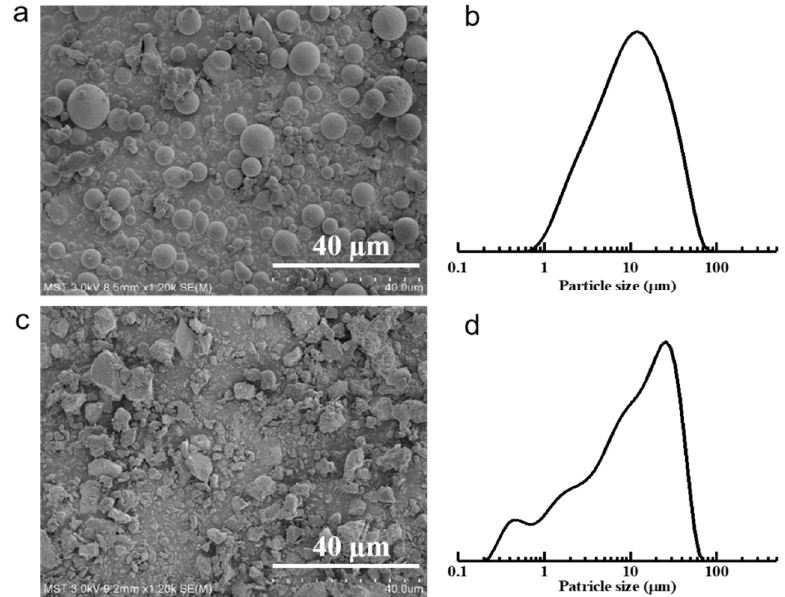
Figure 1. Morphologies and particle size distributions of fly ash ( a , b ) and bauxite ( c , d ).